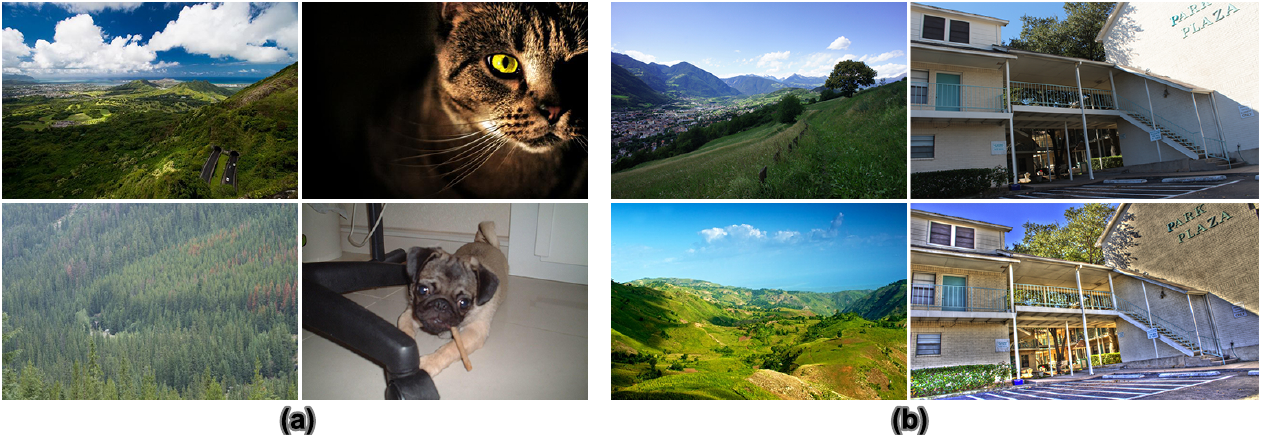
Figure 3. ( a ) IA illustrations: examples of high aesthetic images are in the first row, while the second row contains examples of low aesthetic images. ( b ) IN illustrations: examples of natural images are in the first row, while the second row contains examples of unnatural